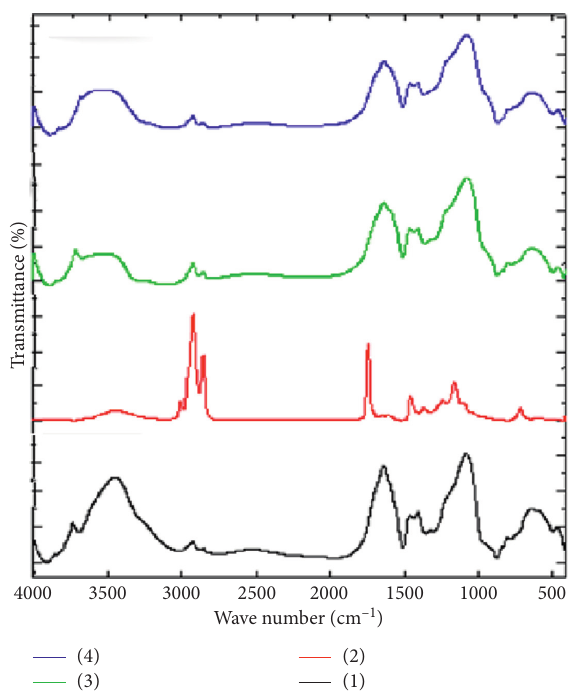
Figure 1: FTIR spectra of GIC, sesame oil, 3 (v/v%) sesame oil- modified GIC and 5 (v/v%) sesame oil-modified